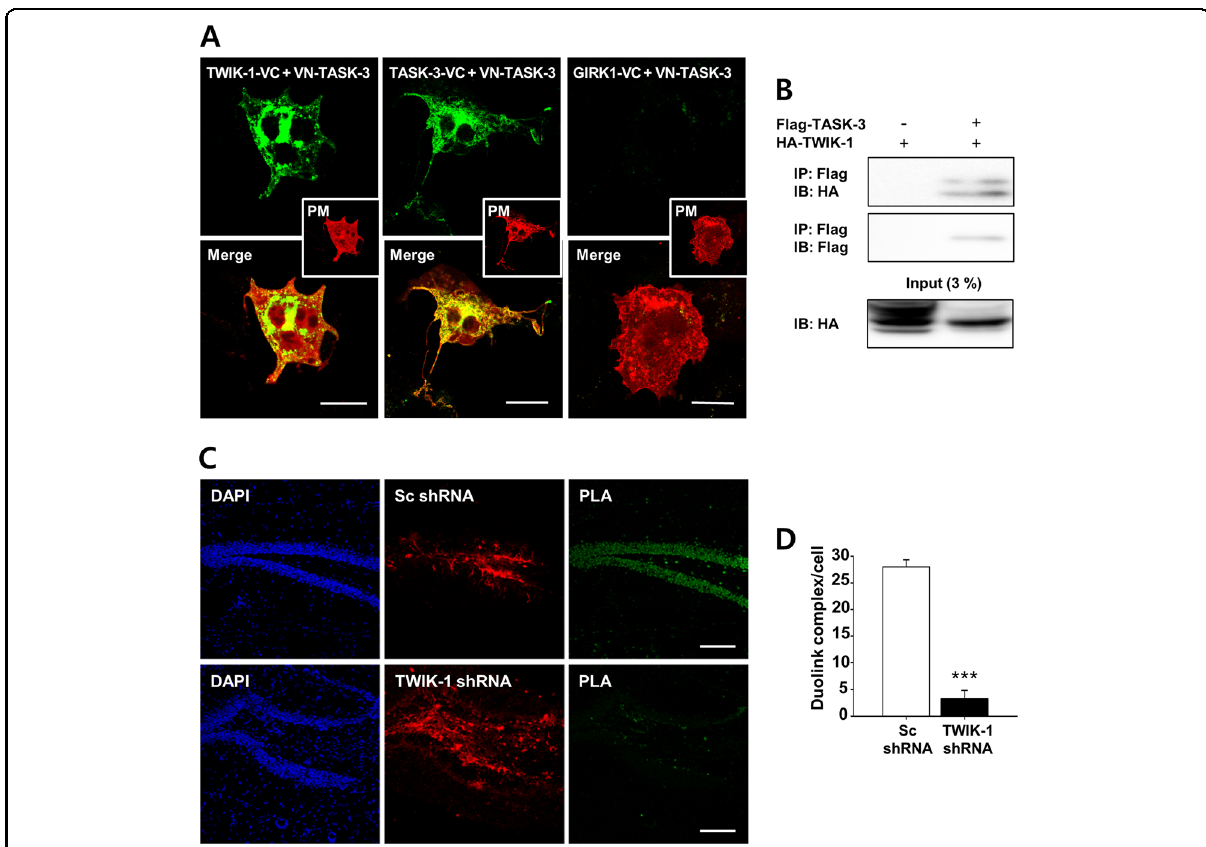
Fig. 2 TWIK-1 forms a heterodimeric channel with TASK-3 in the heterologous system and DGGCs. a Representative fl uorescence images of the bimolecular fl uorescence complementation assay. VN and VC are the N-terminal and C-terminal fragments of the Venus, respectively. Intense Venus signals (green) were examined for dimerization. TWIK-1-VC strongly interacted with VN-TASK-3. The TASK-3 homodimer was used as a positive control, and the GIRK1-VC and VN-TASK-3 heterodimer was used as a negative control (upper). The red images represent the plasma membrane by DsRed-Mem (middle). The merged images showed that TWIK-1 and TASK-3 heterodimers were located in the plasma membrane (yellow color, lower). Scale bar, 10 µm. b The lysates from HEK293T cells transfected as described were subjected to immunoprecipitation with an anti-Flag antibody, and the immunocomplexes were analyzed by immunoblotting with an anti-HA antibody. TWIK-1 coprecipitated only in the presence of TASK-3 (top panel). The expression of these two channels is shown in the lower panels. c Representative images of the Duolink proximity ligation assay in DGGCs infected with Ad-Sc or Ad-TASK-3 shRNAs. Scale bar, 50 μ m. d Quanti fi cation of the Duolink spots in DGGCs expressing Ad-Sc or Ad- TASK-3 shRNAs. *** P <